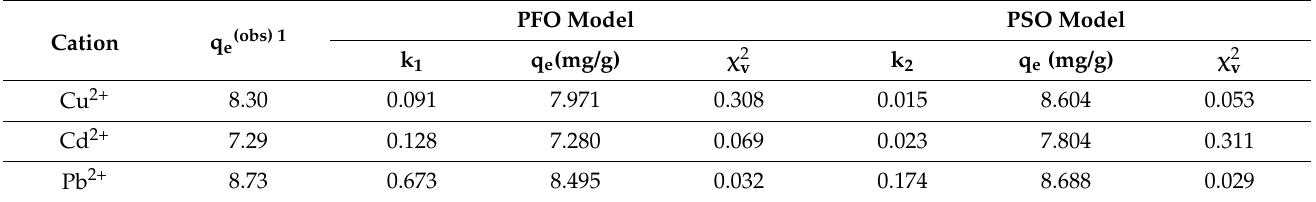
Table 1. One-component adsorption kinetics: Kinetic models and parameters for individual adsorp- tion of Cu 2+ , Cd 2+ and Pb 2+ cations onto the oxidized wool fibers; experimental conditions: T = 300 K,